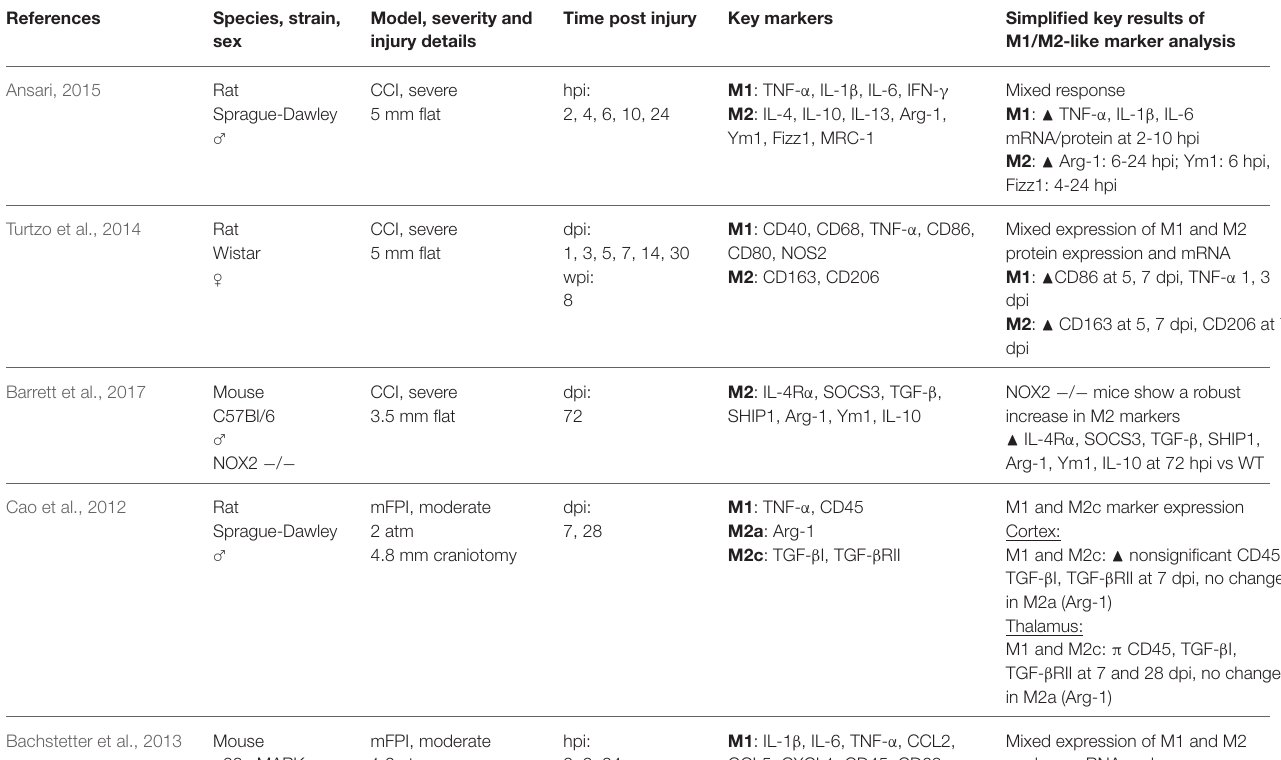
Key markers Simplified key results of M1/M2-like marker